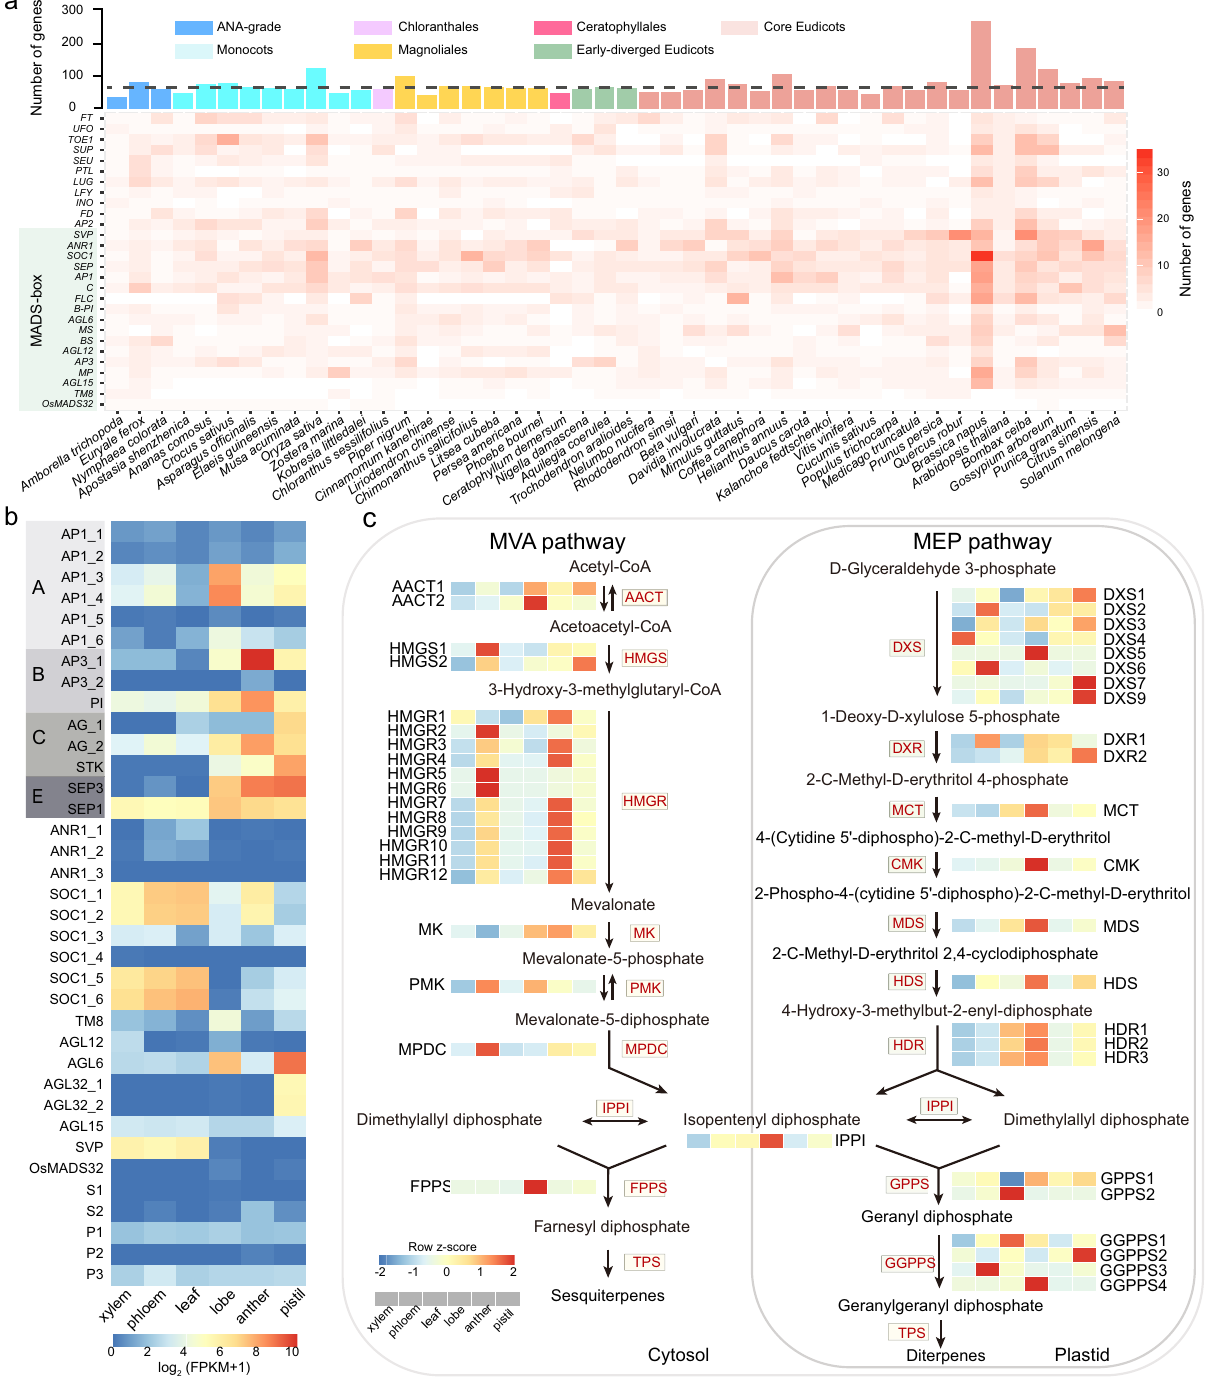
Fig. 5 Evolutionary analysis of fl ower development and terpenoid biosynthesis related genes in C. sessilifolius . a Statistics of the numbers of FDRGs ( fl oral development related genes) identi fi ed in 46 species. The color in each cell of the heatmap represents the number of the corresponding homologs in each species. Warmer color represents higher number of homologs. The bar chart above represents the total number of genes in the corresponding species. b Expression patterns of type II MADS-box genes from various organs (from left to right: leaf, androecial lobes, anther and pistil) of C. sessilifolius . Expression values were scaled by log 2 (FPKM + 1), in which FPKM is fragments per kilobase of exon per million mapped reads. c Terpenoid biosynthesis (MVA and MEP pathways) related genes in C. sessilifolius , and the expression level of each gene was transformed to Z-score across different tissues. Warmer colors indicate high expression levels in both b and c . Source data are provided as a Source Data fi